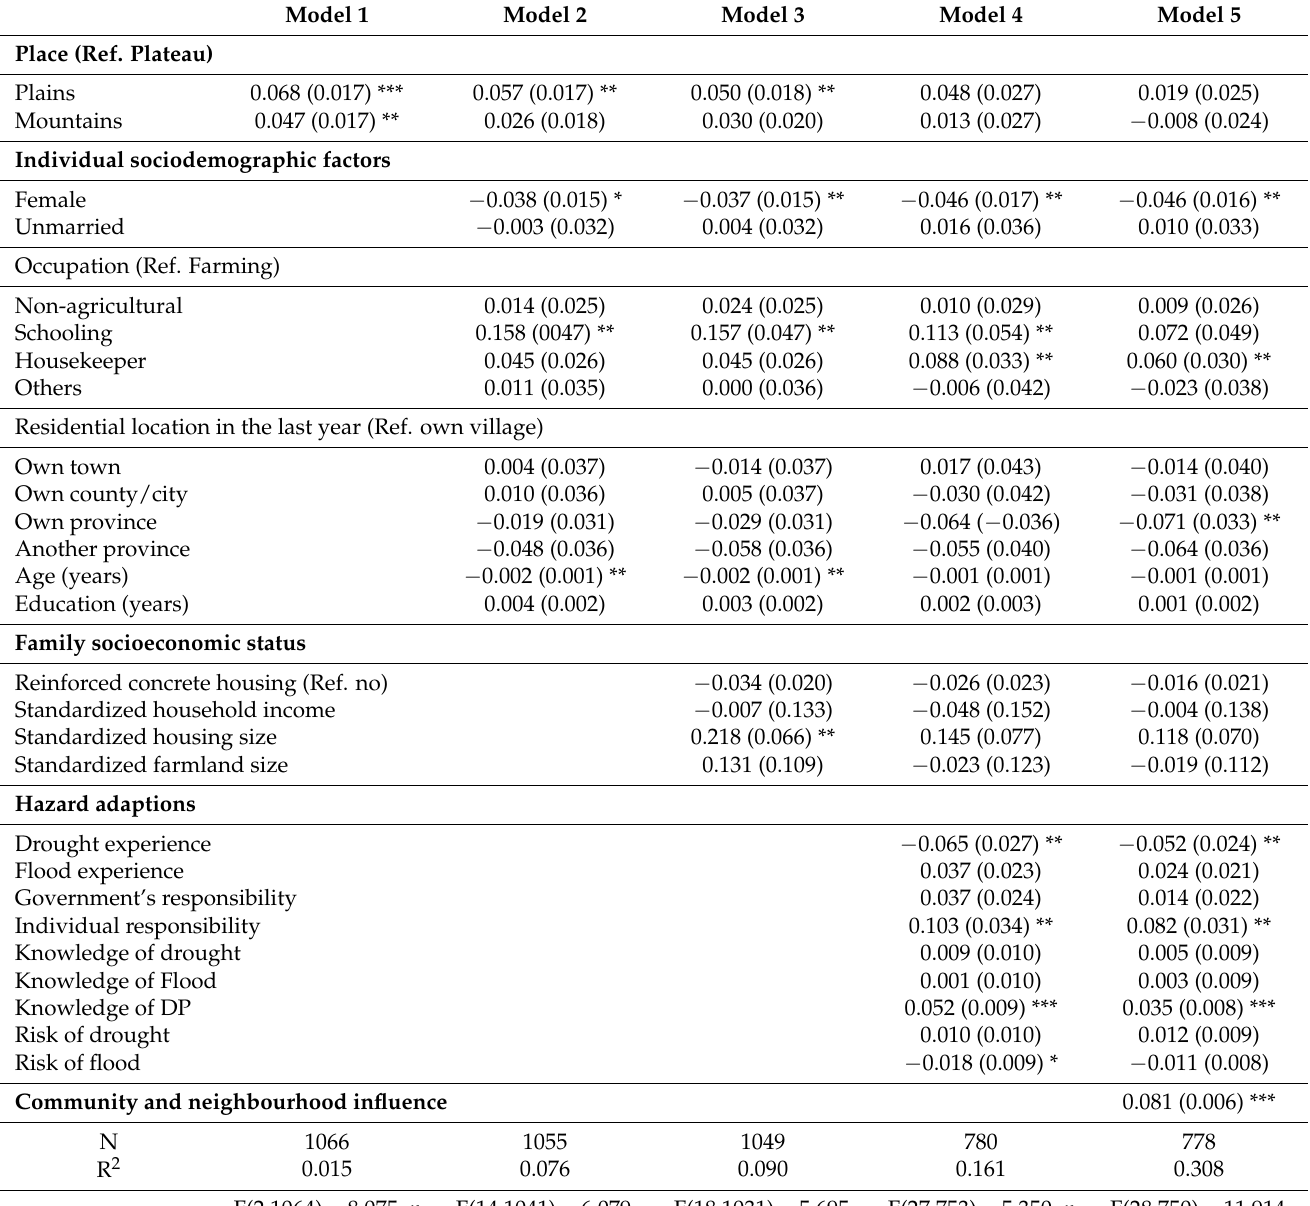
Table 2. Results of multiple regression analyses on individual disaster